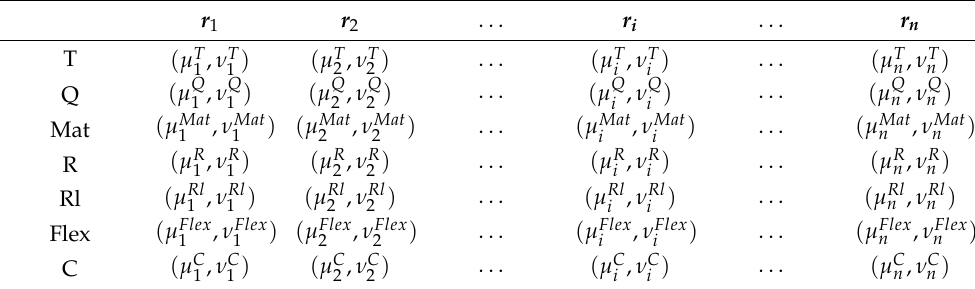
Table 1. Standardized decision matrix for multi-attribute